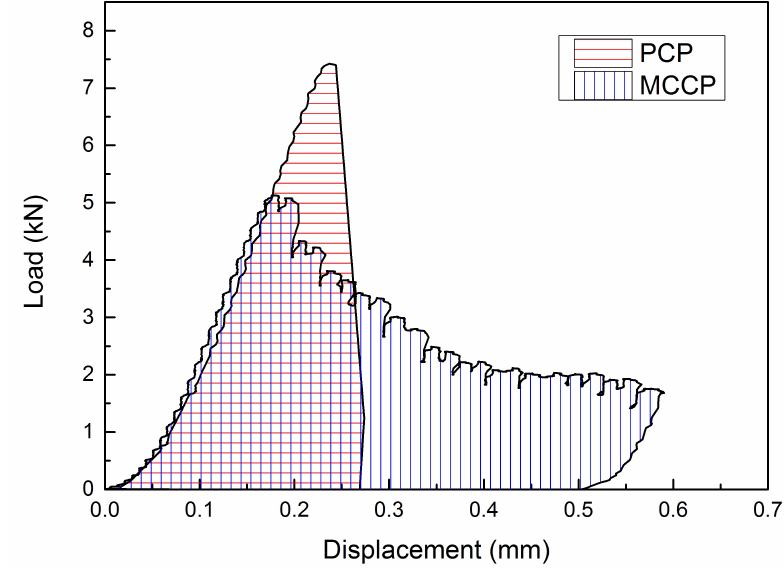
Figure 12. Load–displacement curves of a cement paste sample with and without microcapsules